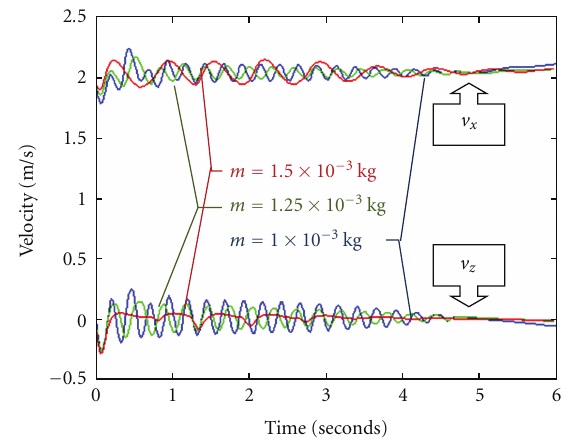
Figure 15: Dragonfly flapping straight—changing the wing area. Distance versus